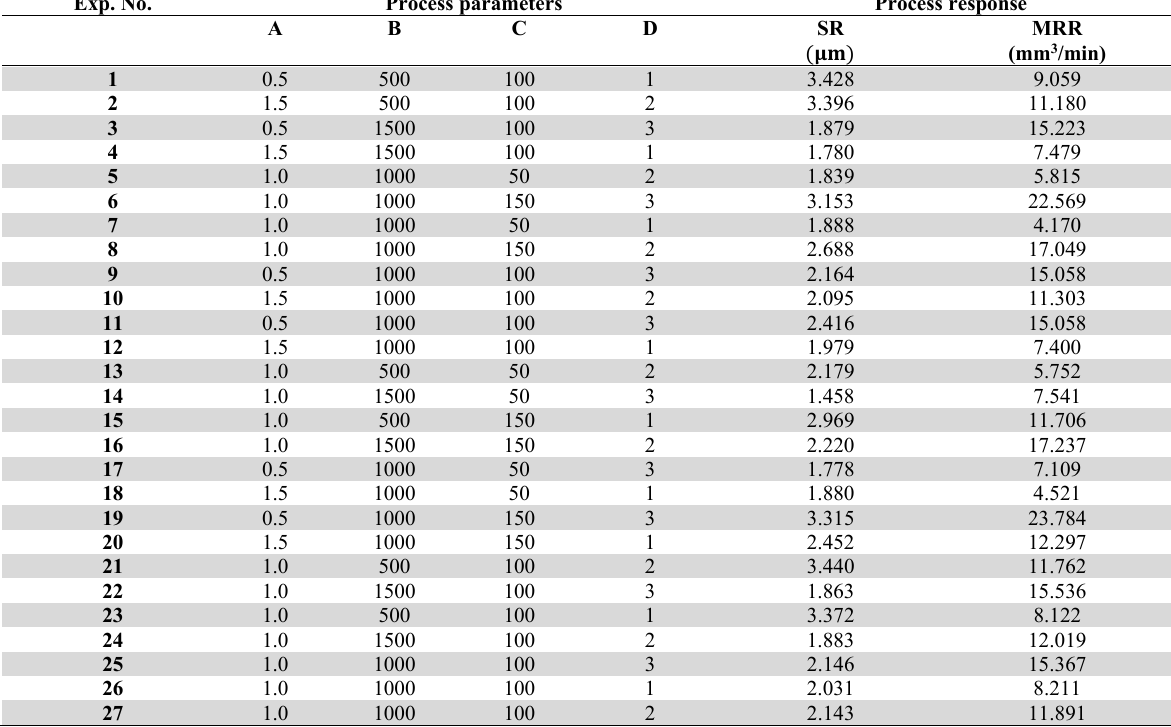
Experimental design and corresponding response value Exp.